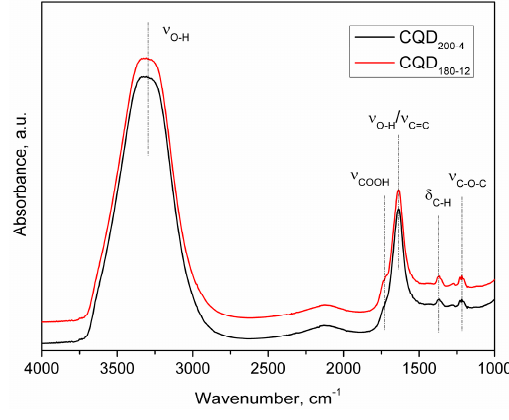
Figure 2. ATR-FTIR spectra in the 1000–4000 cm − 1 range of the CQDs synthesized at 200 ° C and 4 h and at 180 ° C and 12 h.